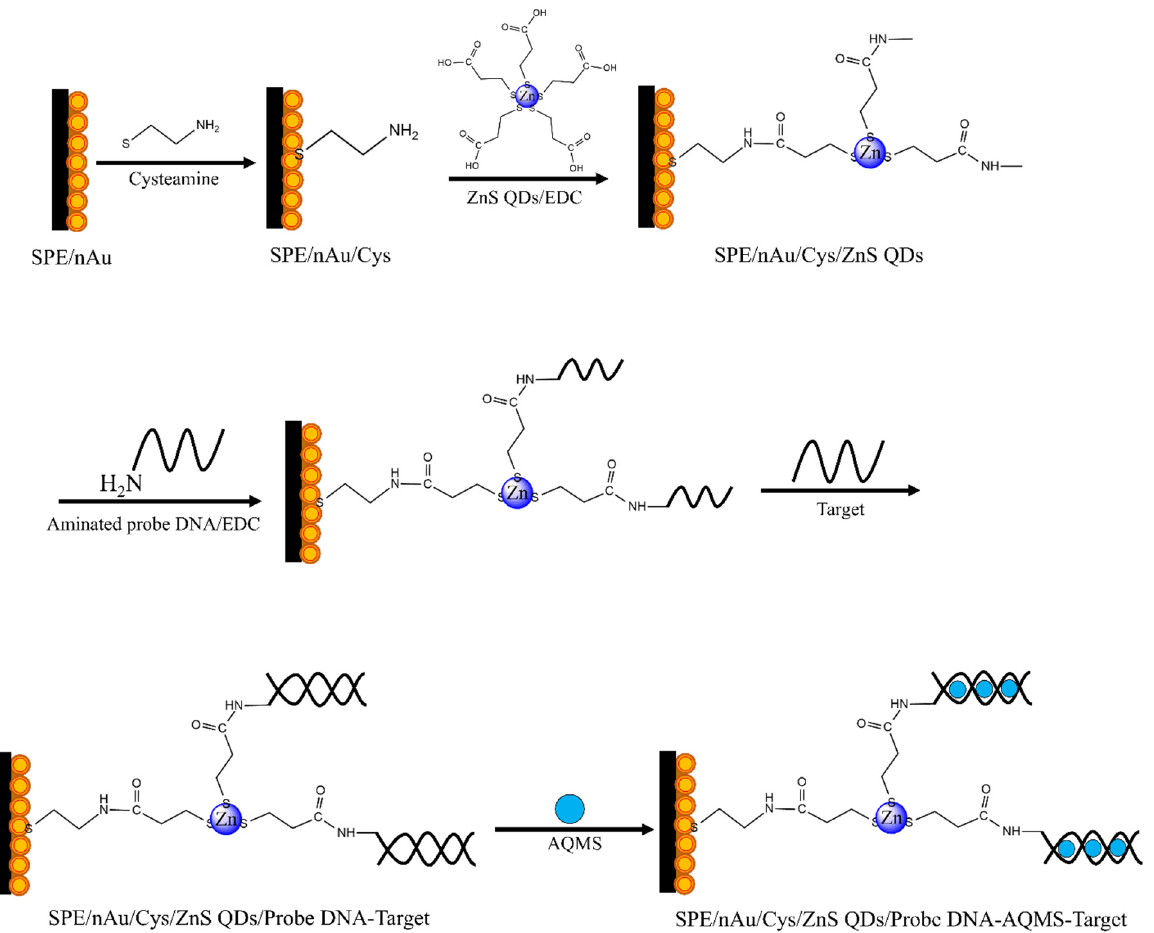
Figure 1. The stepwise construction of the electrochemical DNA biosensor based on multilayer AuNPs, cysteamine linkers and MPA-capped ZnS QDs semiconducting nanoparticles.